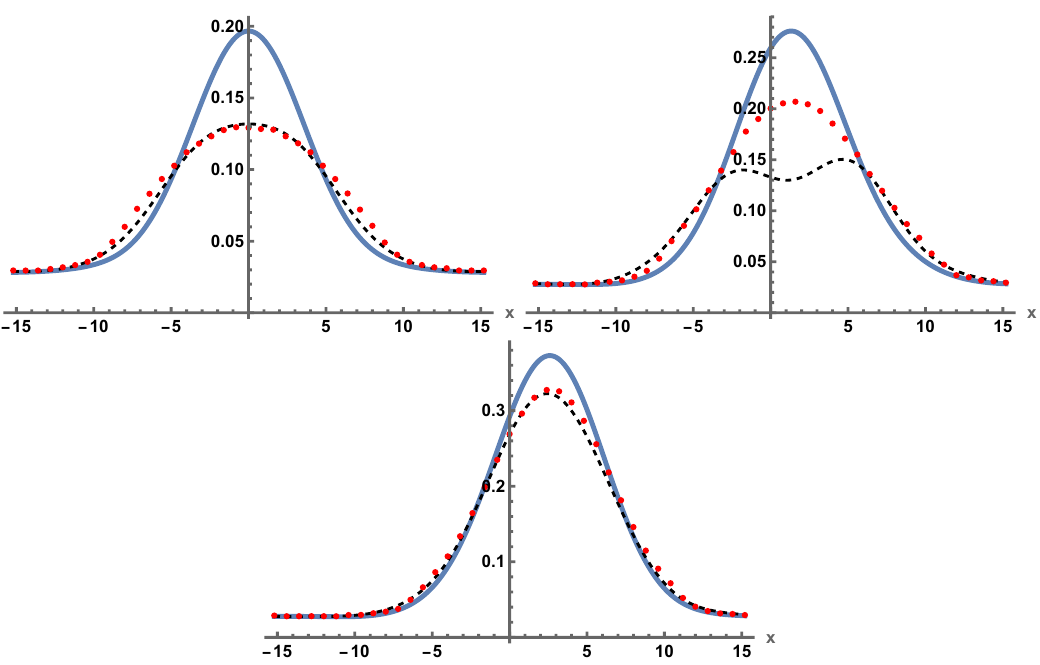
Figure 12 . The energy density at zeroth order (solid blue curve) in the central region y = 0 , z = 0 (top left) and at z = 2 . 1 (top right) and z = 3 . 3 (bottom) at time t = 4 . The red dotted curve represents the exact results, while the black dashed curve includes partial O ( (cid:15) 2 ) corrections discussed in section 4.5. Differences between the exact solution and the truncated transverse derivative expansion continue to increase with time, such that long after the hydrodynamization time they become substantial. Therefore, it appears to be a fluke that the (partial) second order corrected solution and the exact solution for vanishing z fit so well in the top left